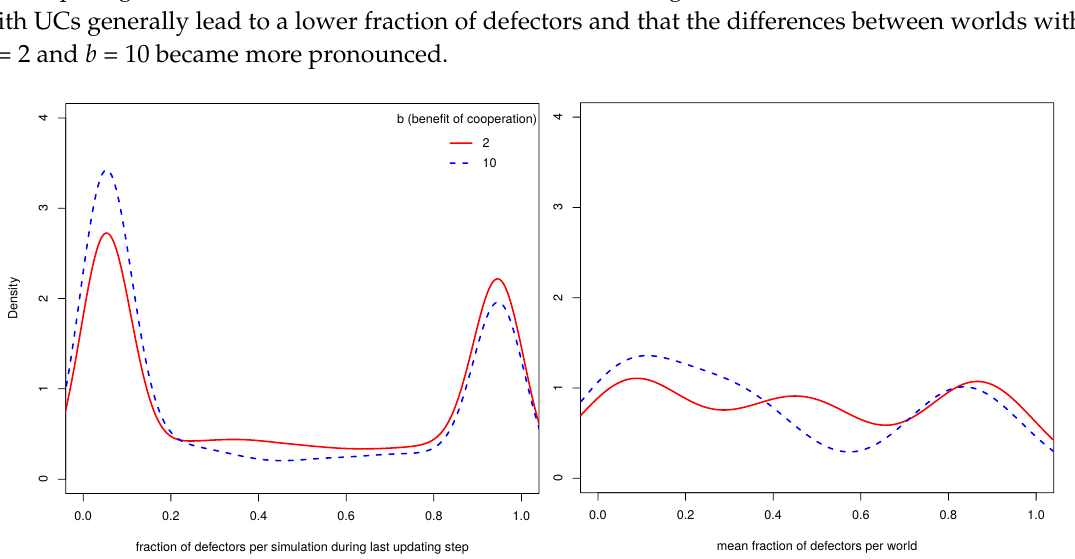
Figure 2. Distribution of the fraction of defectors across all simulations (left) and the per world distribution of the means of the fraction of defectors